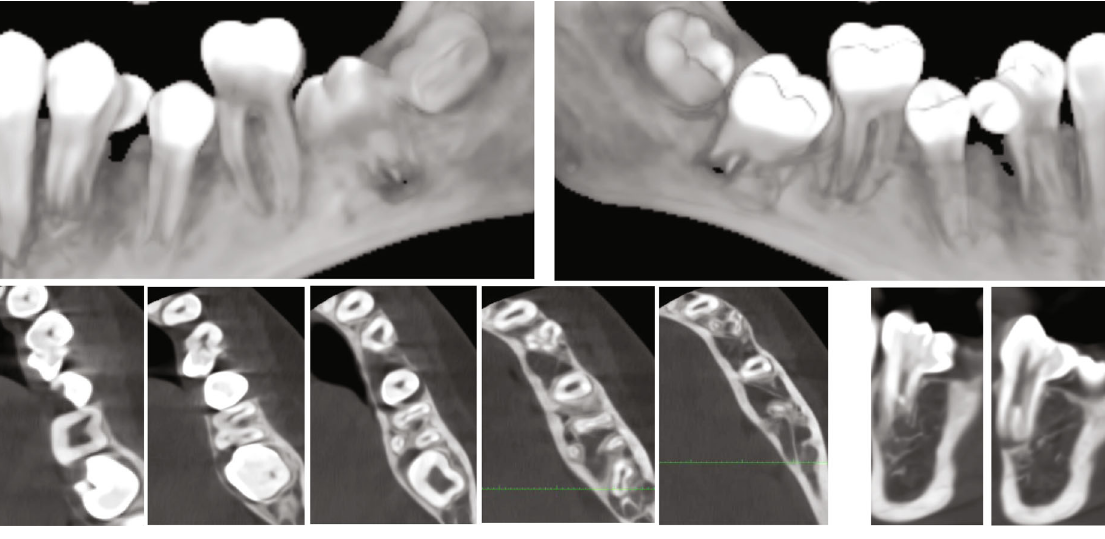
Figure 8: CBCT: 3D vestibular and lingual view and transverse